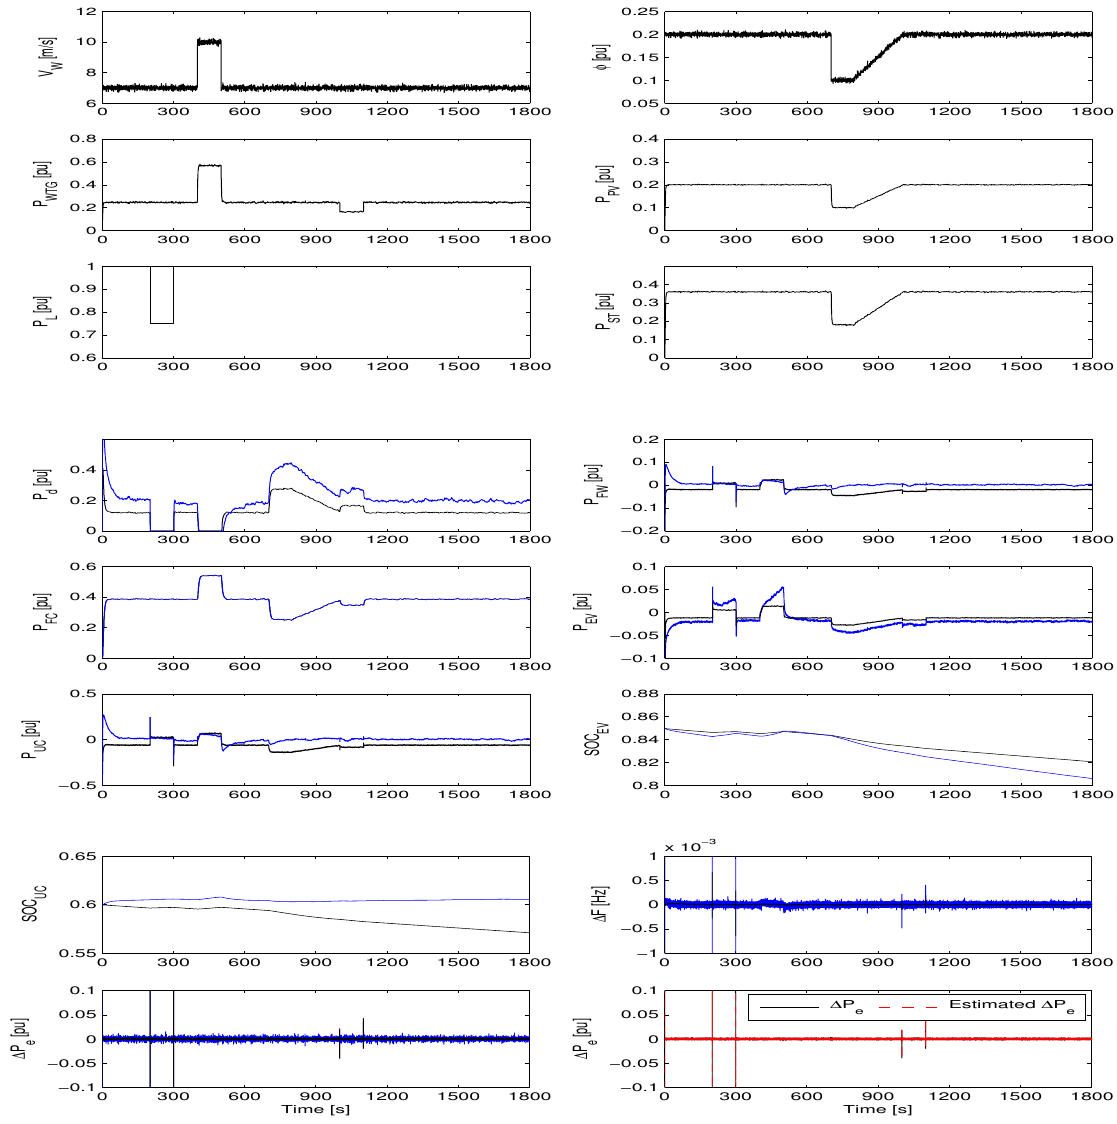
Figure 16. Case 2 simulation results: PF (black), FLC